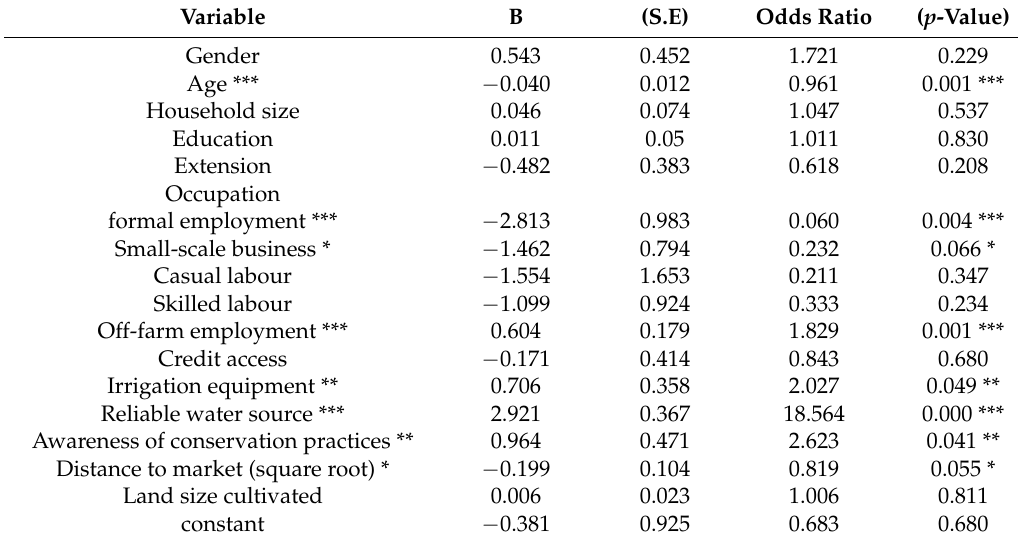
Table 5. Parameter estimates of the binary logistic regression model for factors influencing the adoption of irrigation in the Chinyanja